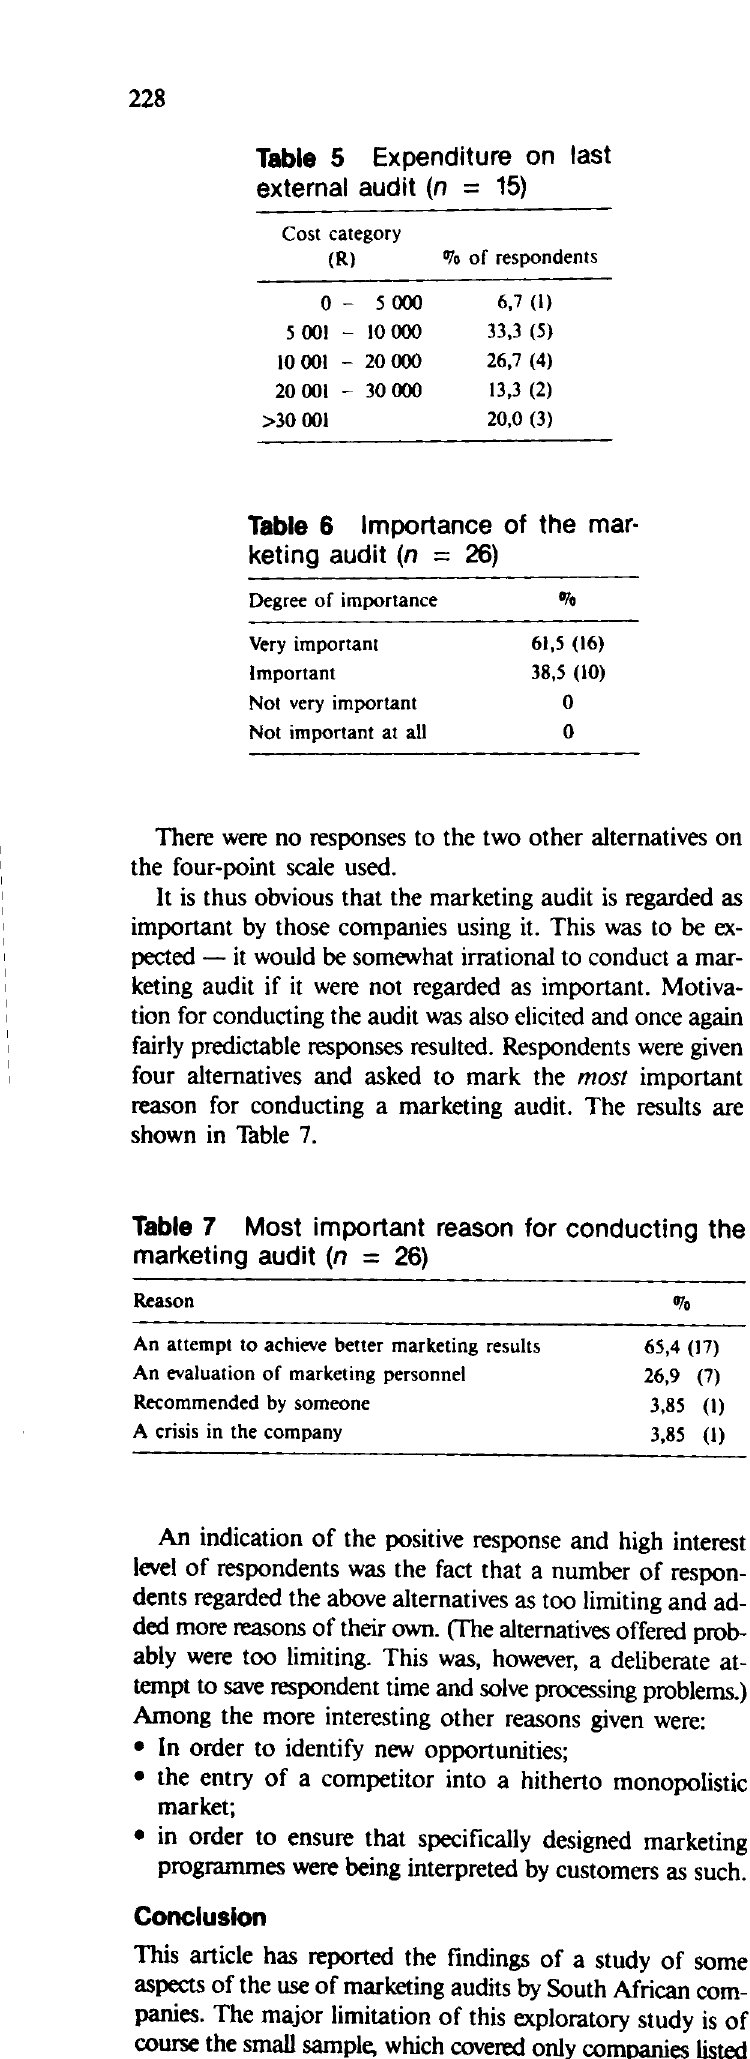
Importance of the